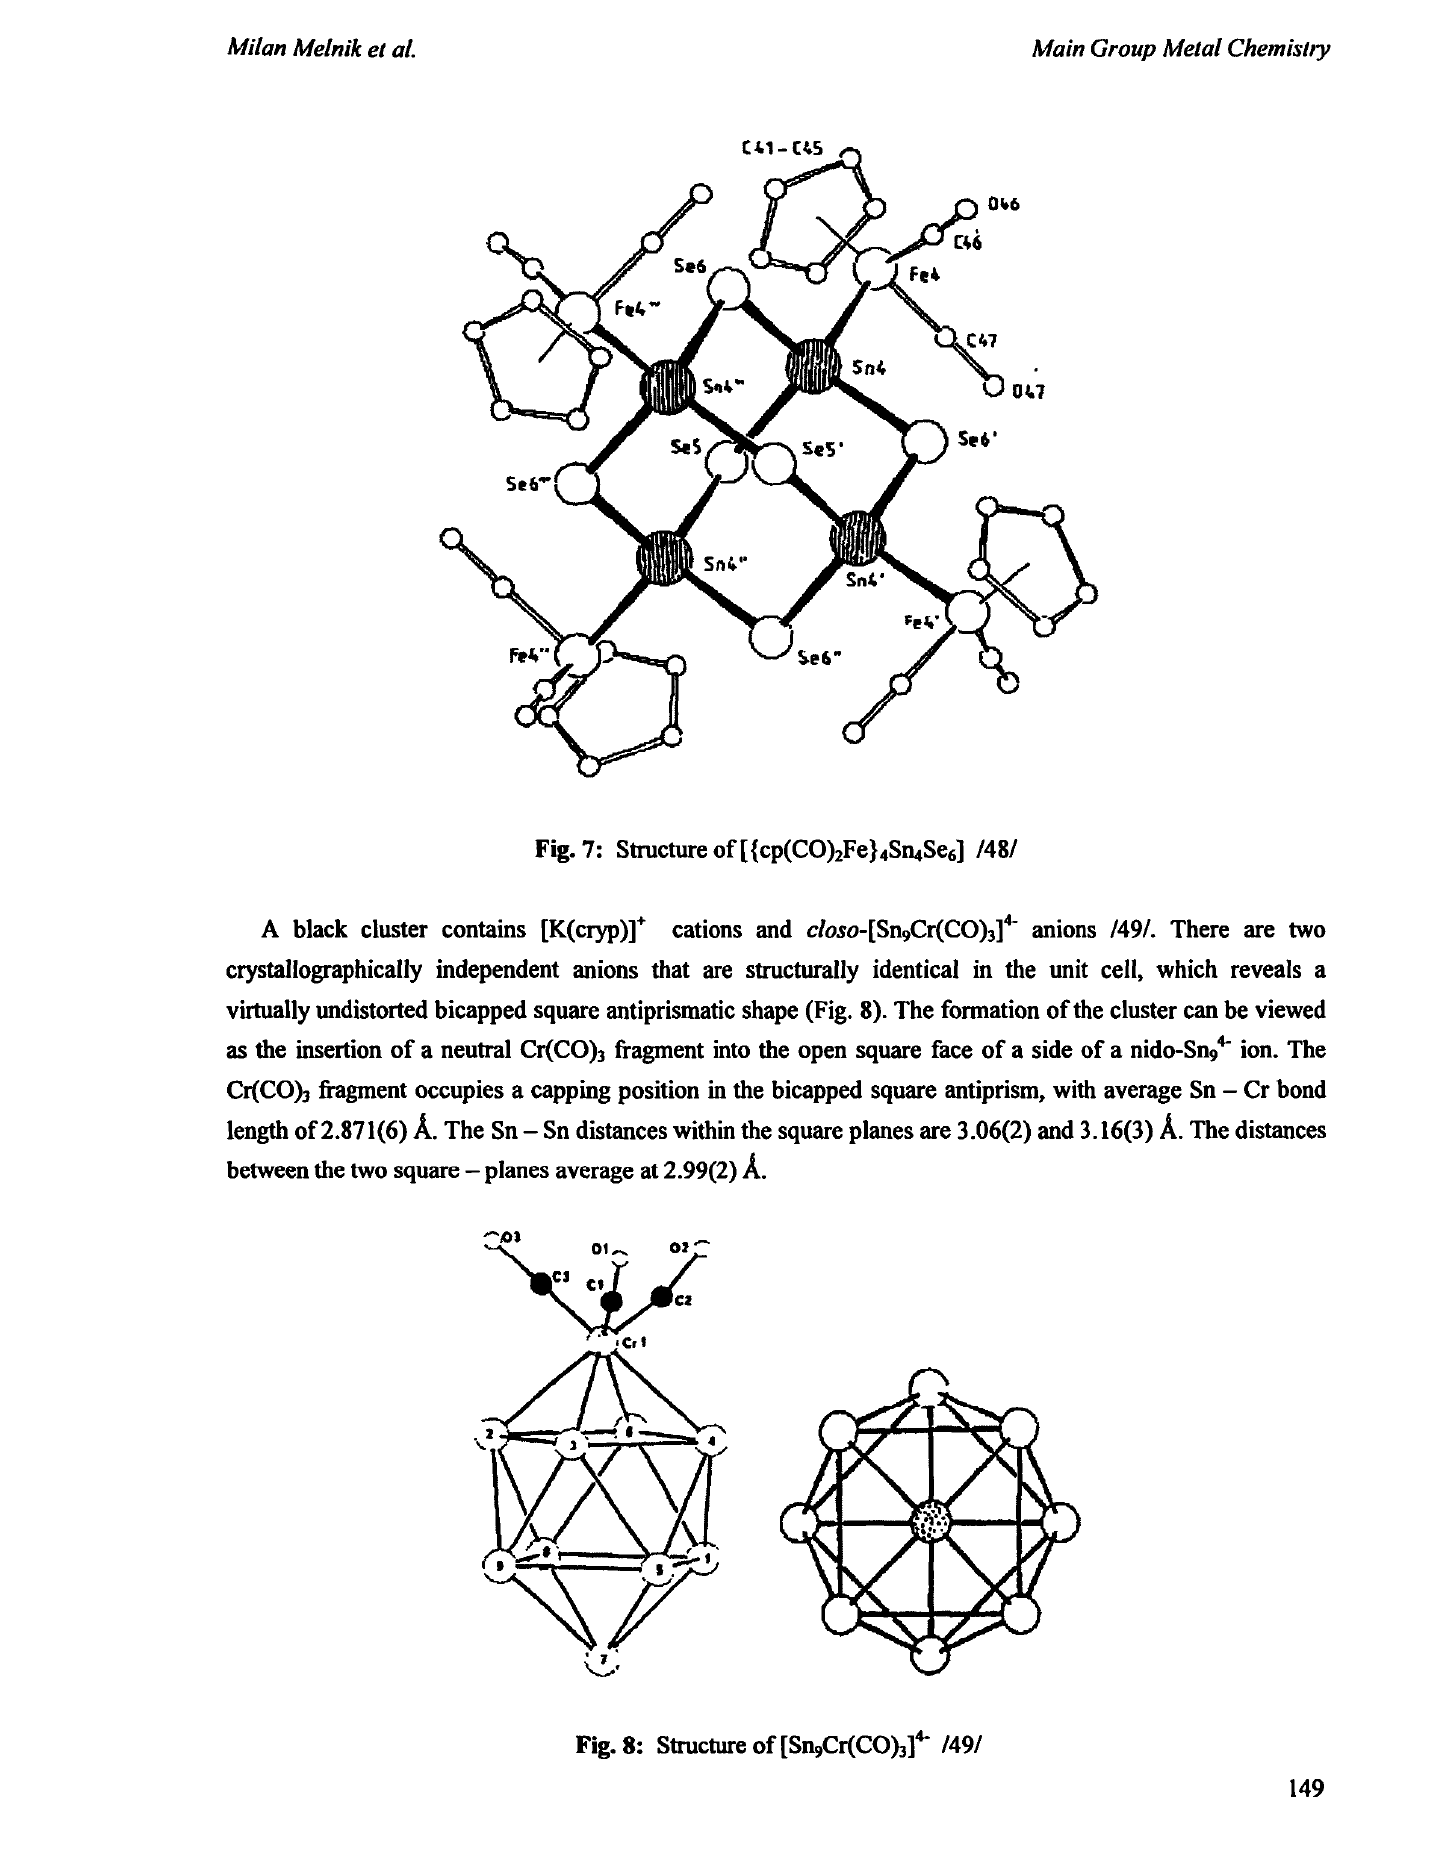
Fig. 7: Structure of [{cp(CO)